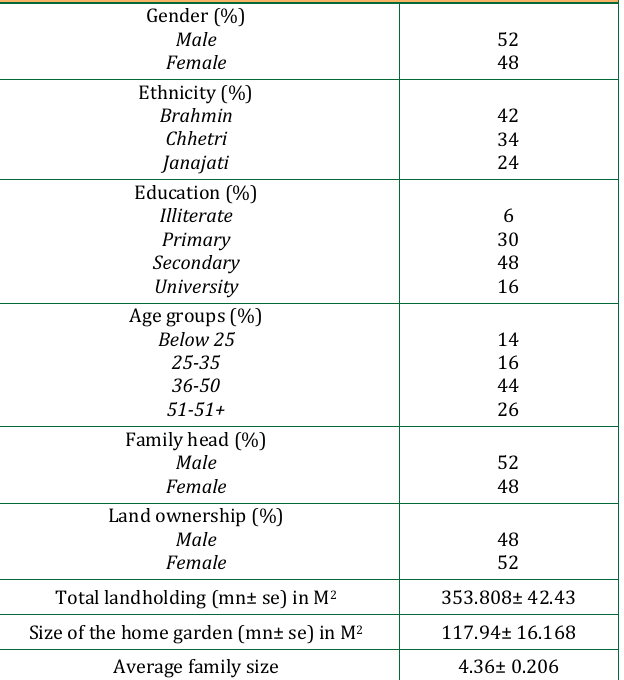
Figure 1: Map of Itahari Sub-Metropolitan Municipality showing study area (Anonymous, n.d.) 2.2. Research design, sampling size, and data